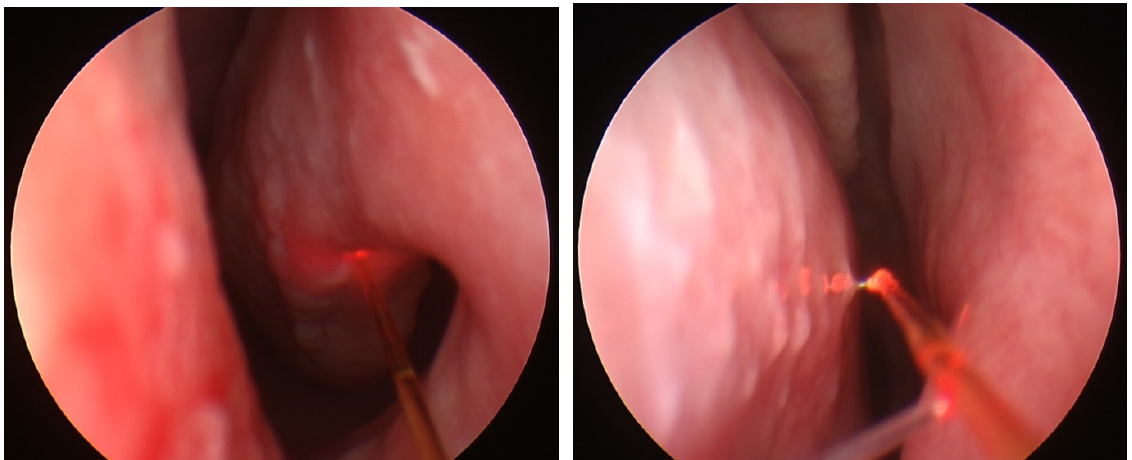
Figure 2. Laser assisted separation of adhesions in nasal septum.